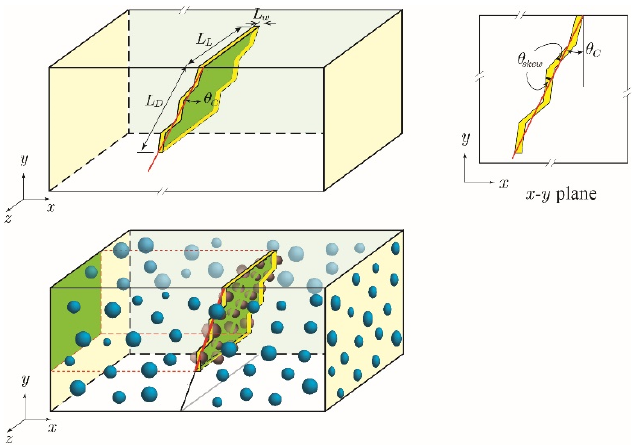
Figure 1. Idealized crack and definition of crack